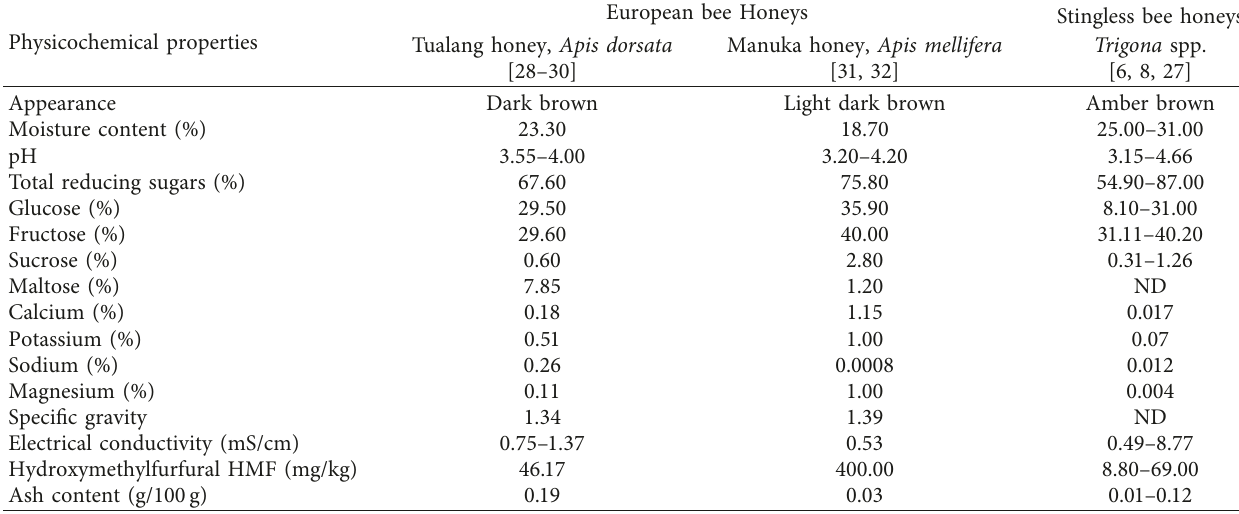
Table 1: Different physicochemical characteristics of European bee honey and stingless bee honey. Physicochemical